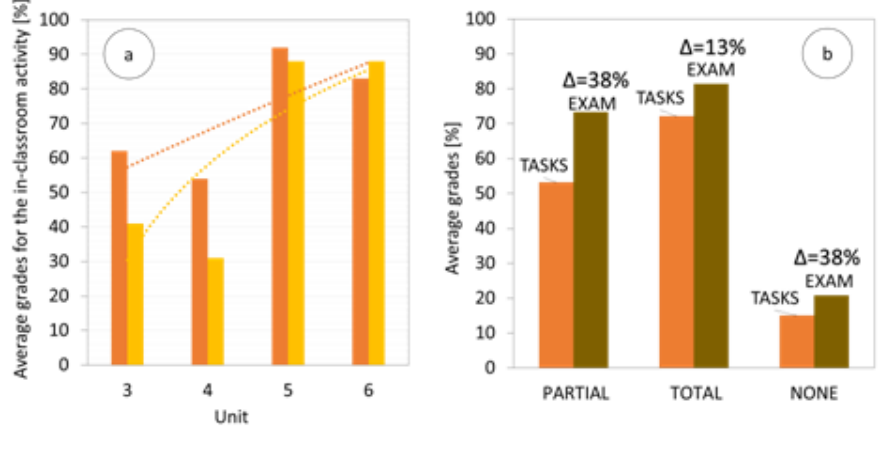
Figure 8. Analysis of the results in the pilot group: a) Average achieved grades for every unit, as a function of the students’ degree of involvement in the learning strategy: Students that participated in both activities and those that participated only in the in-classroom activity; b) Effect of the involvement degree on the final examination